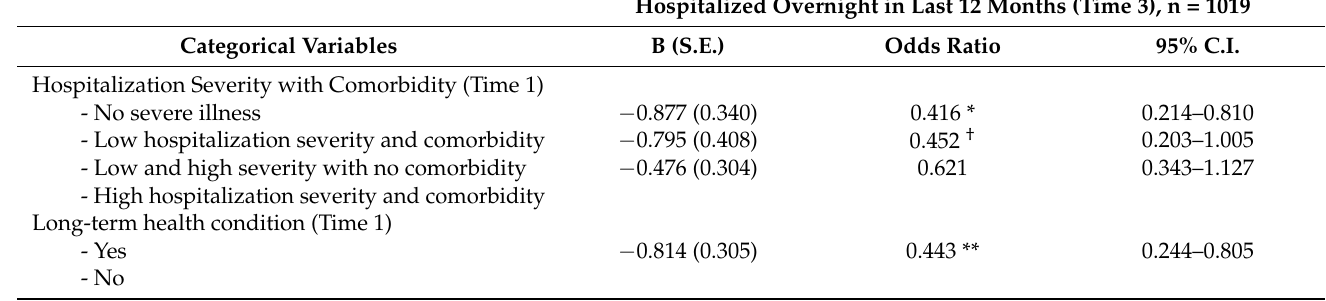
Table 2. The parameters of the logistic regression results for having overnight hospitalization at Time